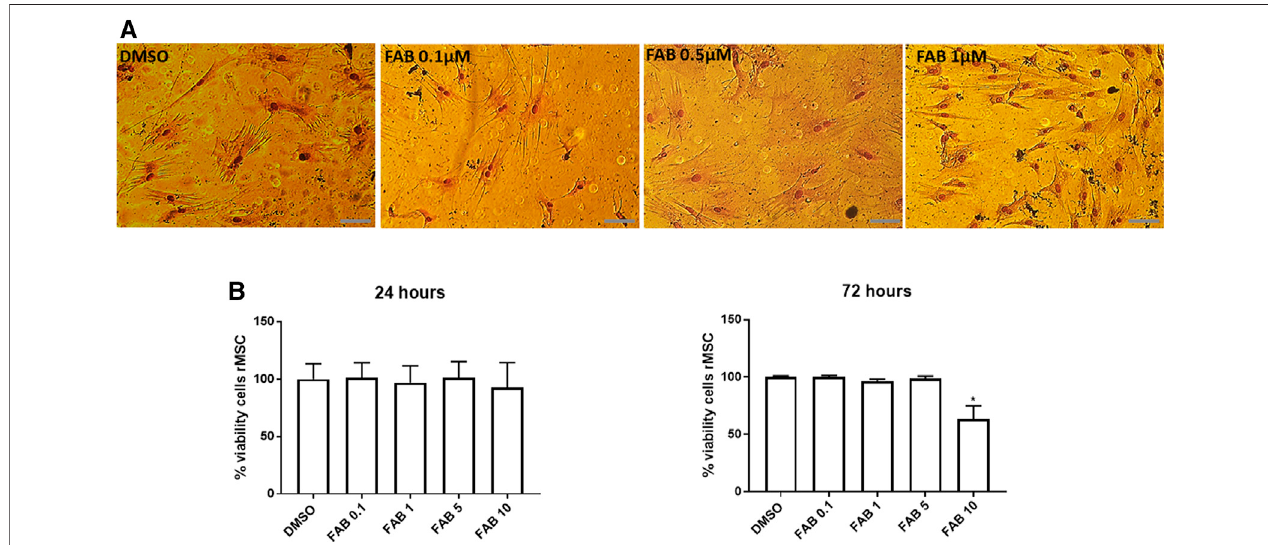
FIGURE2 |(A) Morphological aspect of 30days in vitro (DIV) ofrMSCs ofcultures in control conditions (0.01% DMSO) and 72 hafter treatment with FAB (0.1, 0.5 and 1 µM); Rosenfeld staining; obj. x40, scale bar 50 µm. After treatment with 0.1 and 0.5 µM FAB, the cells presented a fl at polygonal morphology similar to that of the control(DMSO).However,aftertreatmentwith1 µMFAB,thecellspresentedY-shapedextensions. (B) AnalysisofviablerMSCsofculturesincontrolconditions(0.01% DMSO) and 24 and 72 h after treatment with FAB (0.1, 1, 5 and 10 µM), showing no toxicity in 24 h and toxicity only for FAB 10 µM 72 h after treatment; MTT test; Each graph is representative of three independent experiments and the data are expressed as means ± standard deviation. An ANOVA one-way test followed by Turkey ’ s test for multiple comparisons was